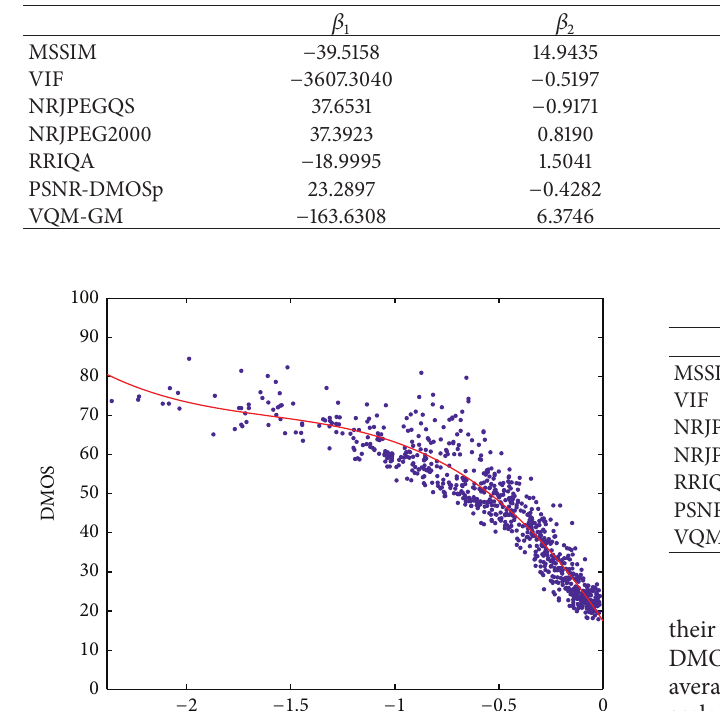
Table 1: Equation parameters of metrics under study.